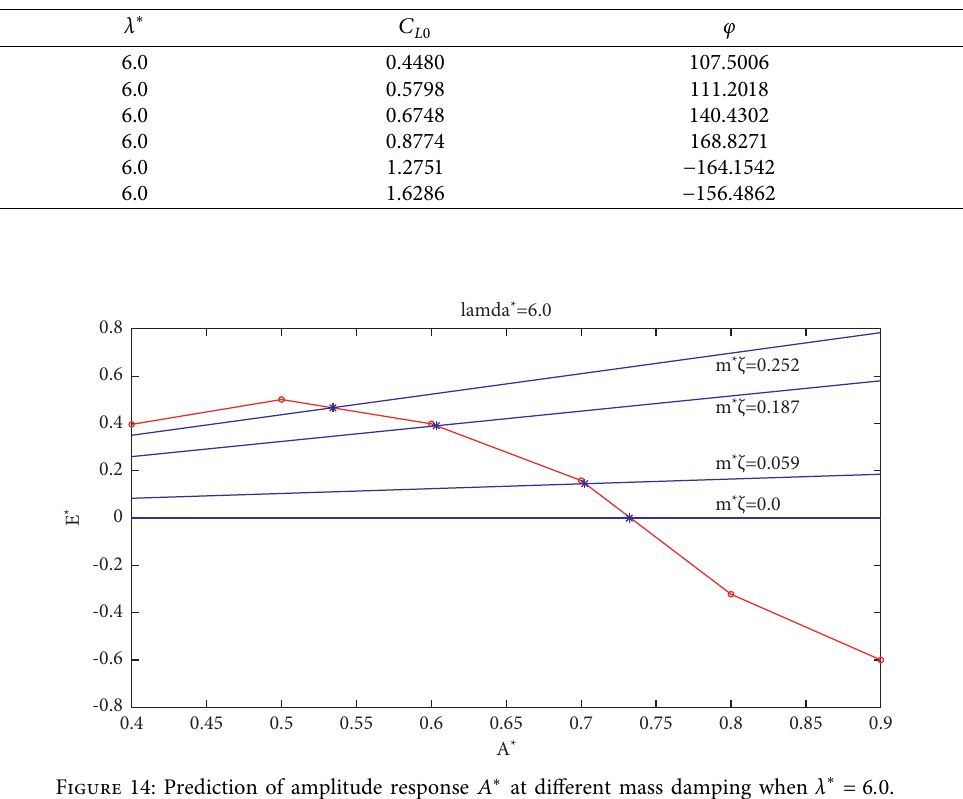
Table 6: Forced oscillating response at different amplitude ratio A ∗ at λ ∗ � 6 . 0.